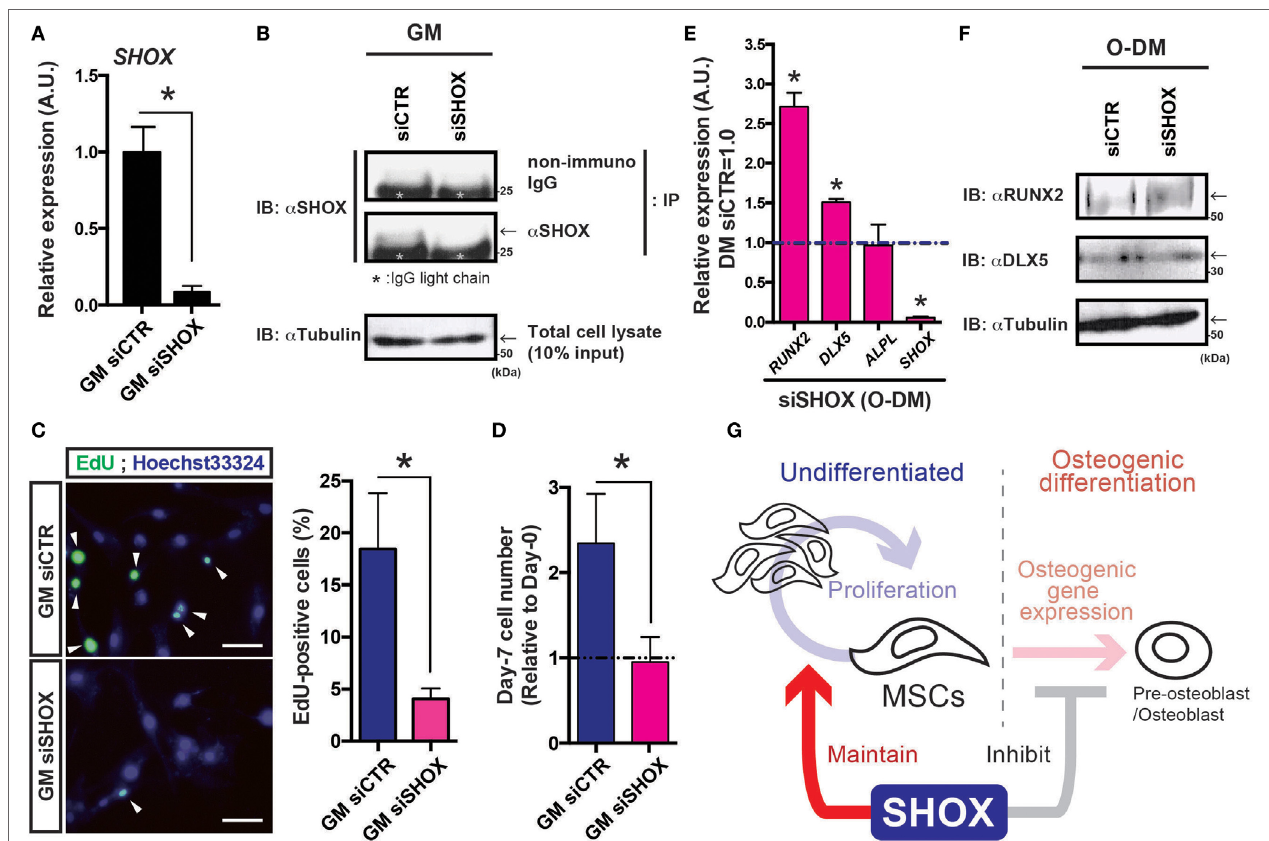
FigUre 4 | Reduced expression of SHOX hampered cell proliferation in human mesenchymal stem cells (hMSCs) under undifferentiated condition and disrupts osteogenic gene expression under differentiation-induction condition. (a) Changes in SHOX gene expression by siRNA in hMSCs. At the 4 days post siRNA transfection, total RNA was extracted from the cells and the levels of SHOX gene expression were examined by quantitative real-time (qRT)-PCR analysis. Data are mean ± SEM, three independent experiments. * P < 0.05. GM: growth medium. (B) Cell lysates were prepared at the 3 days post transfection of each siRNA and the changes in SHOX protein level are assessed by immunoprecipitation (IP) followed by immunoblotting (IB) using indicated antibodies/IgG. The IgG light chain is marked with asterisk. Arrows indicate the expected SHOX signal just above the IgG light chain. Tubulin was detected as an internal control. (c) The EdU assay was performed to test DNA synthesis of siRNA-treated cells under GM condition. Representative pictures and quantification data are shown. Arrowheads indicate EdU signals. Data are mean ± SEM, three independent experiments. * P < 0.05. (D) Changes in cell proliferation in undifferentiated hMSCs. The relative cell numbers are expressed by showing the value in initial (day-0) as 1.0, and the value in day-7 was compared. Data are mean ± SEM, three independent experiments. * P < 0.05. GM: growth medium (e) qRT-PCR analysis of SHOX , ALPL , DLX5 , RUNX2 genes in hMSCs under osteogenic differentiation condition. Data are mean ± SEM, three independent experiments. * P < 0.05. Undiffer., undifferentiated hMSCs; Osteo., hMSCs under osteogenic differentiation at day-4. (F) Cell lysates were prepared at the 4 days post transfection of each siRNA and the changes in protein levels of RUNX2, DLX5, and tubulin were assessed by IB using indicated antibodies. Arrows indicate the expected signal. (g) Schematic illustration of working hypothesis. The shox / SHOX expressed in mesenchymal stem cells (MSCs) maintains cell proliferation in early developmental period. On the other hand, during the osteogenic differentiation, shox / SHOX may coordinate the proper timing of the specific gene expression(s) required for differentiation process. Through these actions in MSCs, shox / SHOX regulates normal skeletal growth and